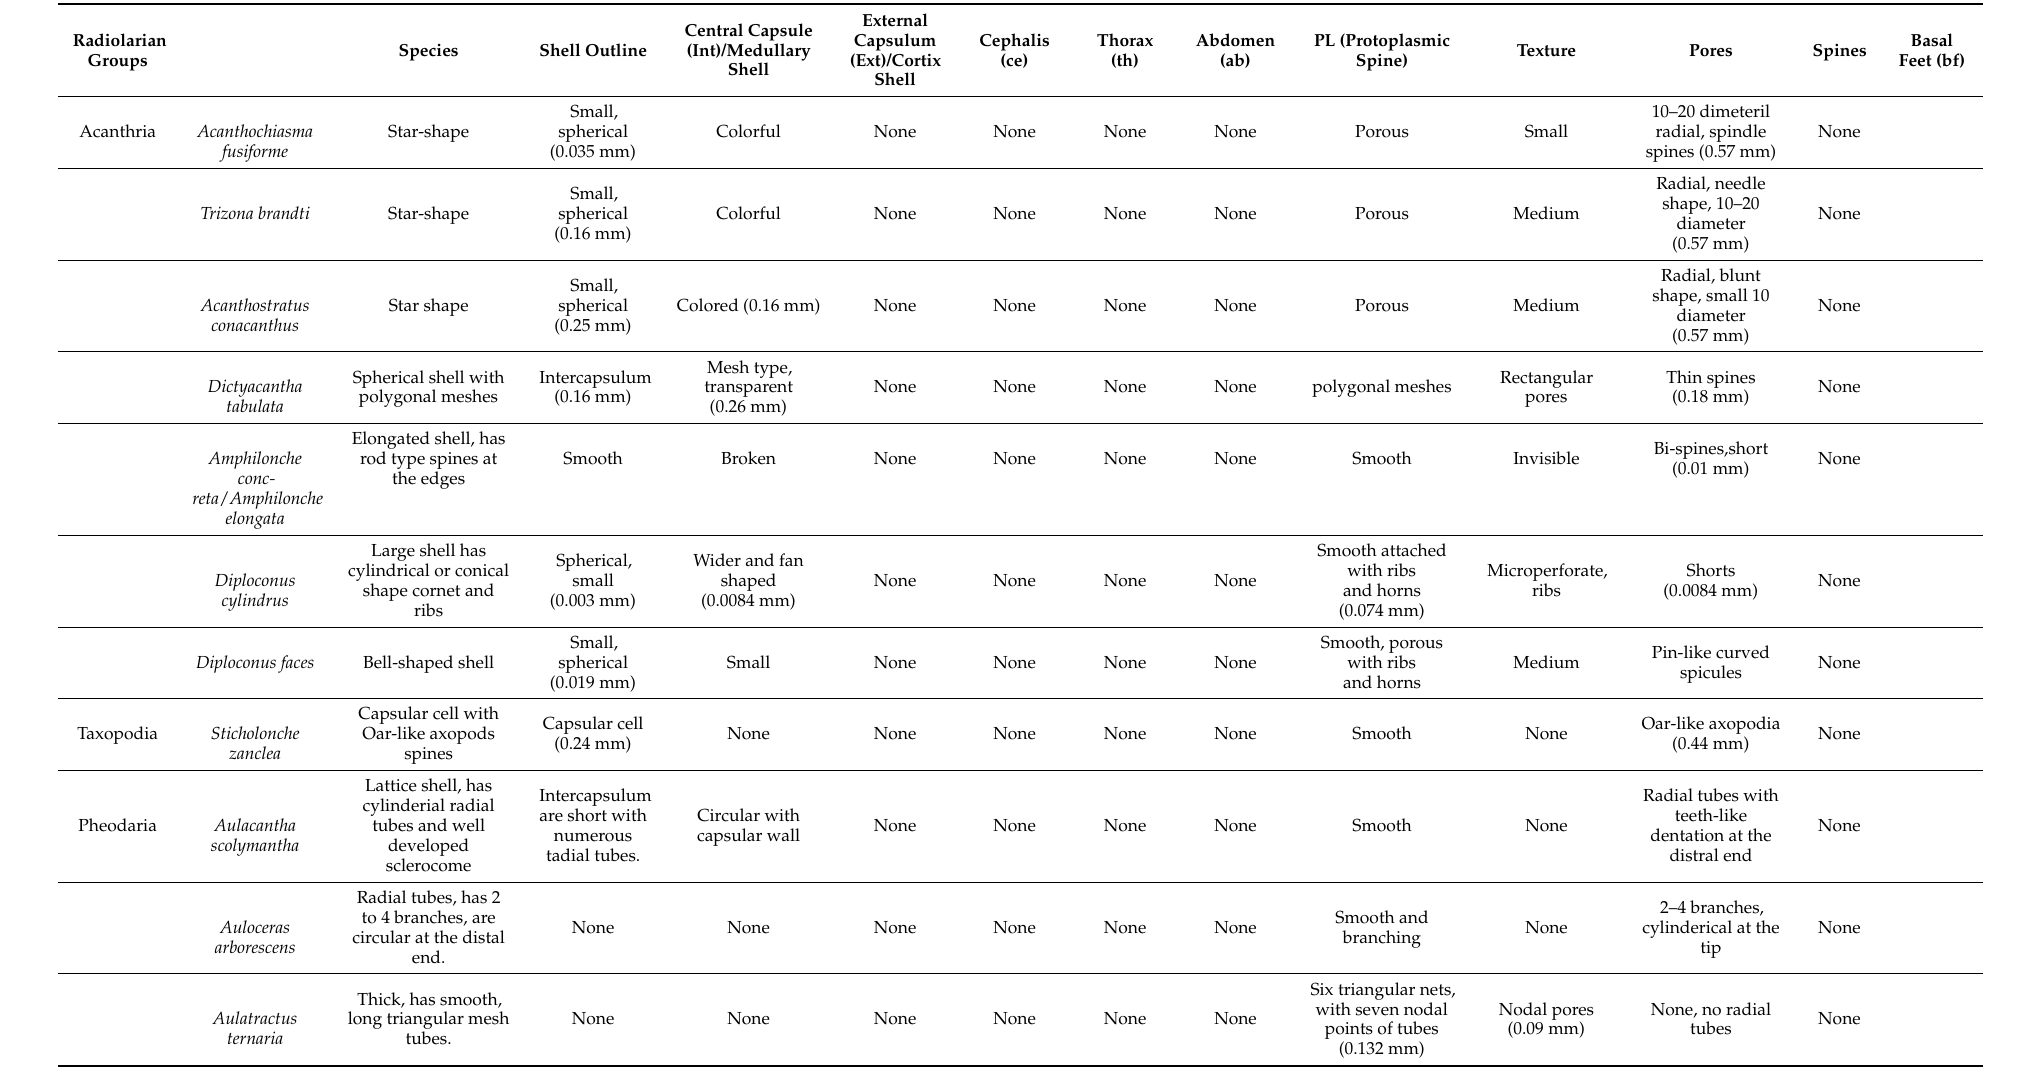
Table 2. Systematic notes and morphometric measurements of the newly recorded species of the eastern Indian